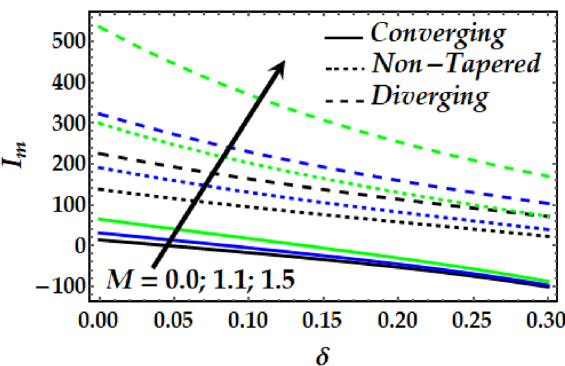
Figure 15. Impedance profile against distinct values of M .